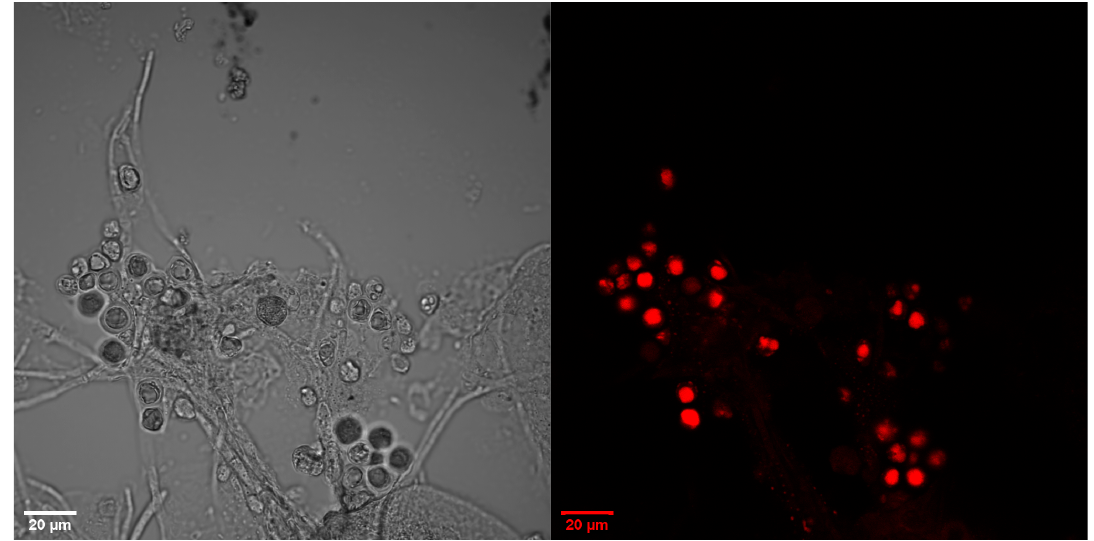
Figure 10. Microscopic images (objective 60×) of the sample observed in visible light and after using Nile Blue A procedure with red filter and blue laser excitation.